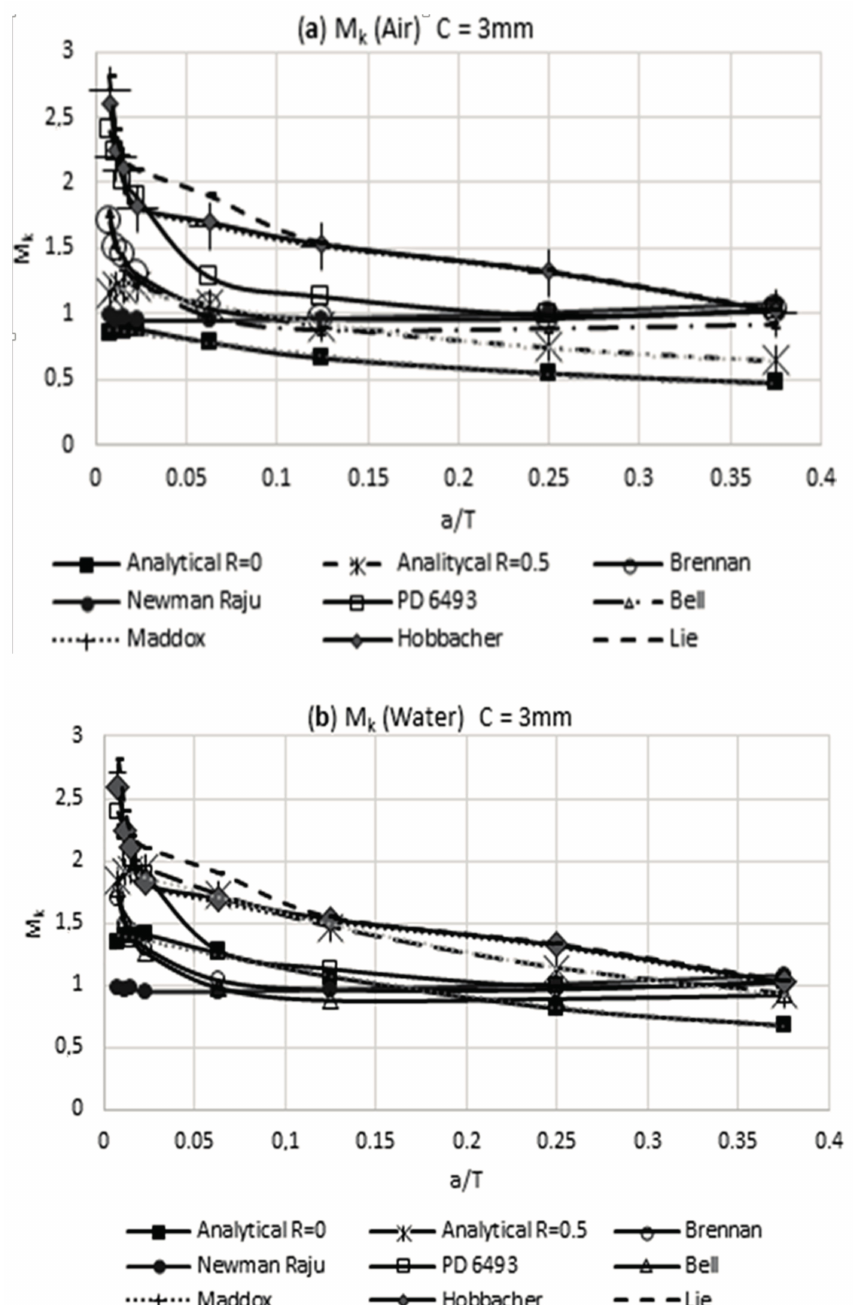
Figure 10. Modified weld magnification factor M k with the presence of residual stress vs. other researchers: ( a ) air and weld size of 3 mm and ( b ) water and weld size of 3